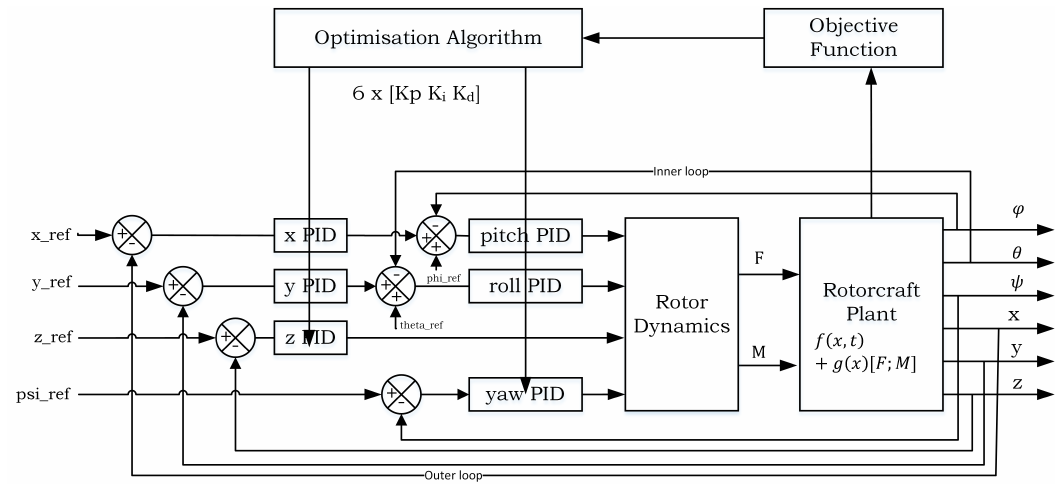
Figure 3. PID closed-loop system showing the objective function and the optimisation algorithm used to update the PID controller